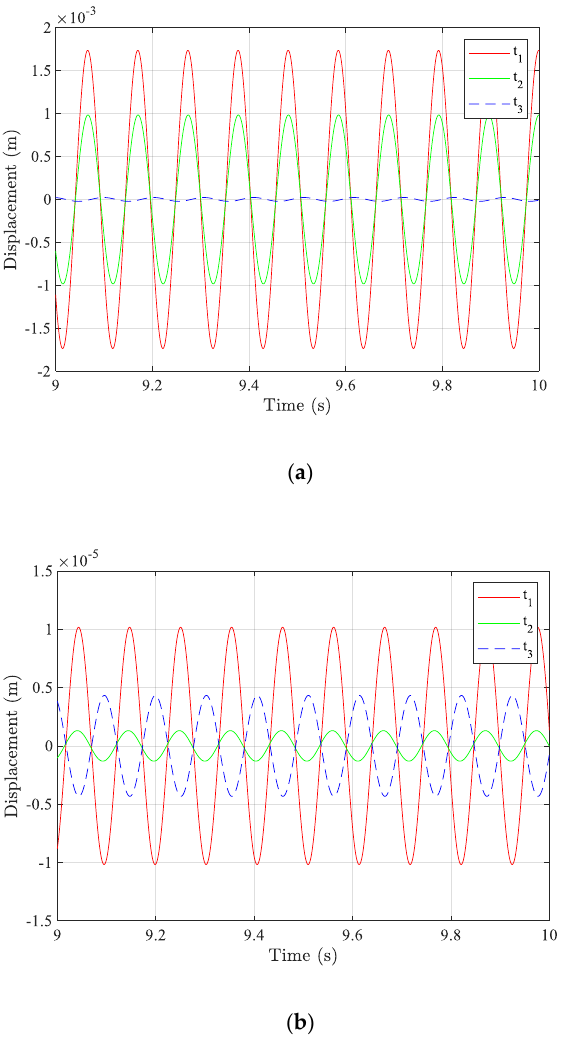
Figure 6. The response of sinusoidal disturbance. ( a ) Open-loop. ( b ) Under LADRC controller.